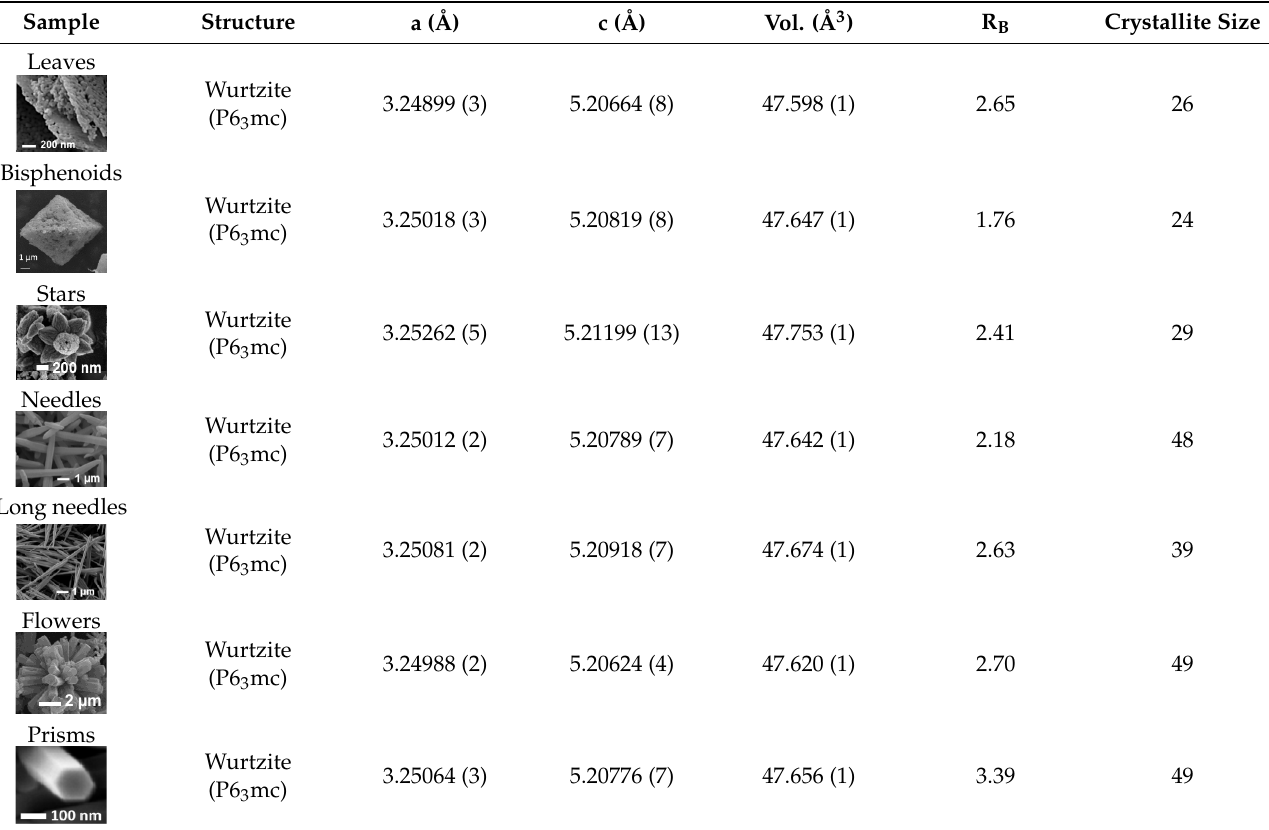
Figure 5. XRD patterns of the ZnO morphologies compared with that of reference. Table 1. Crystalline phase, the unit cell parameters values: a, c, and volume, Bragg R factor, and crystallite size for all ZnO morphologies. In parentheses, the estimated standard deviations are referred to the last digit.